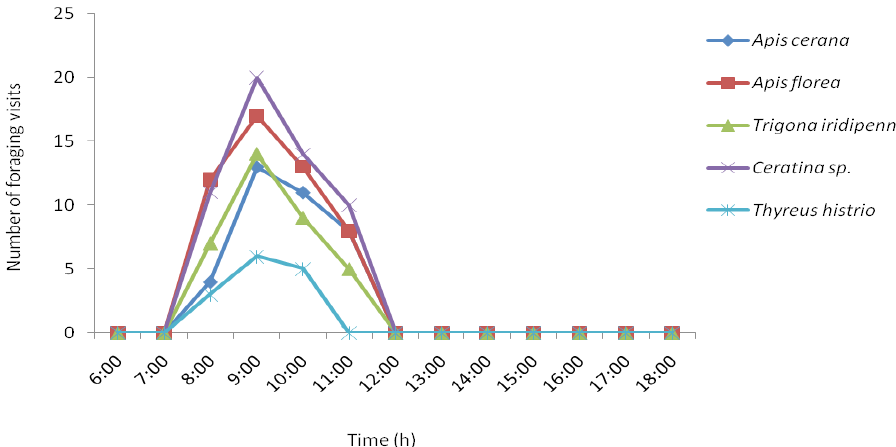
Figure 3. Hourly foraging activity of bees on Mollugo